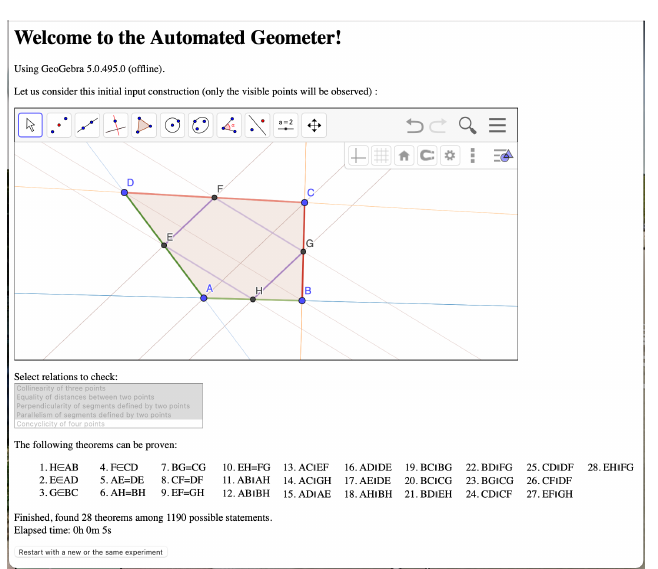
Figure 6. The Automated Geometer at work, finding in 5 s 28 theorems concerning the selected relations: collinearity of three points, perpendicularity, parallelism of lines, or equality of segments, holding over the given